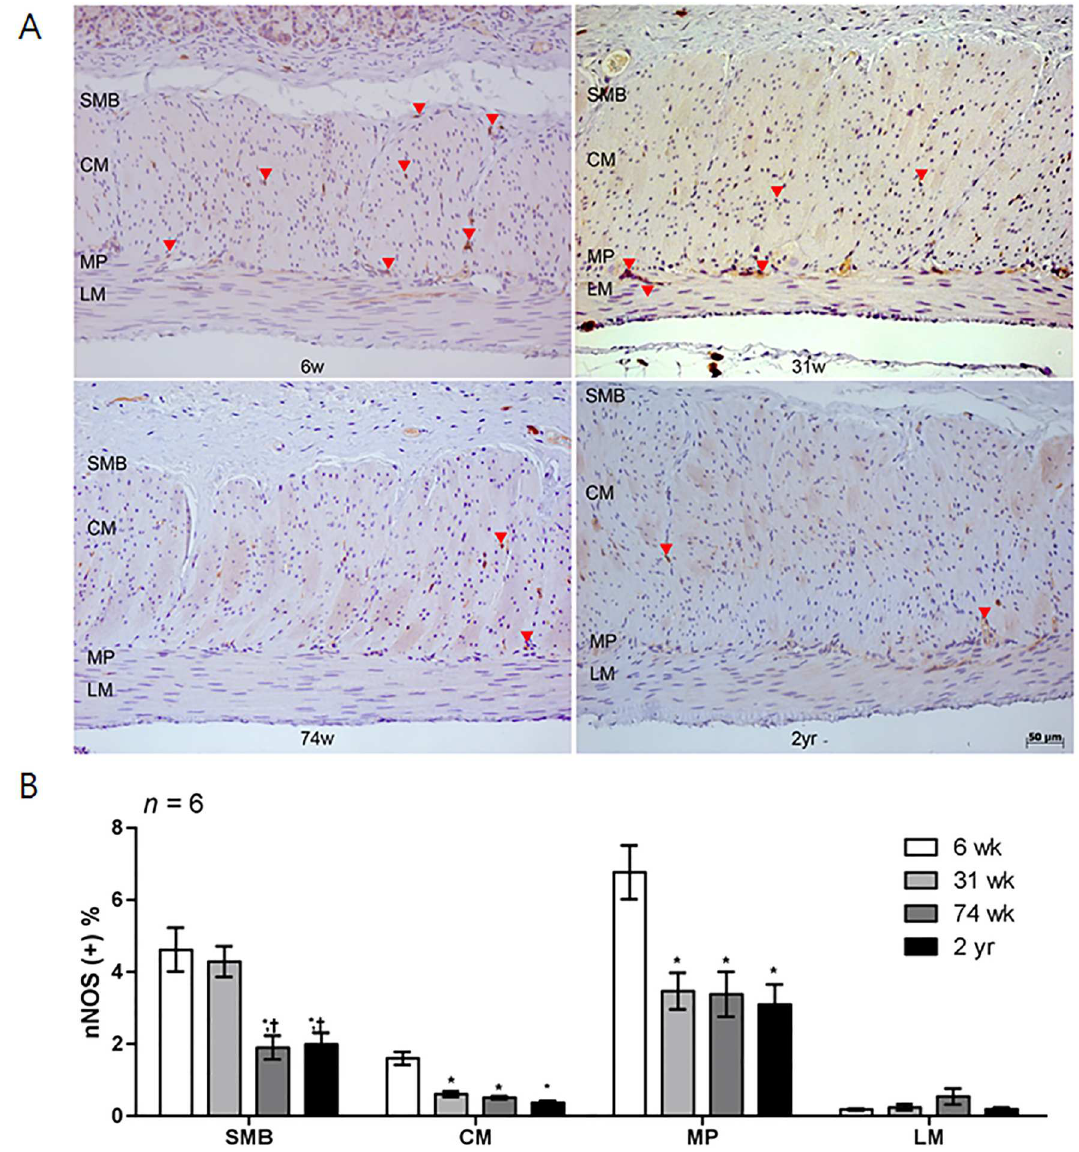
Fig 6. Analysis of nNOS immunohistochemistry. (A) Photomicrograph of nNOS immunostainingof the corpus of rat stomach. Arrows and arrowheadsindicate the nNOS-positive nerve fibers and neuronalganglion,respectively(x200 magnification). (B) Comparison of the nNOS positive area ( n = 6 per group). The proportionof the nNOS immunoreactive area decreased with age. Each bar represents the mean ± SE. SMB, submucosalborder; MP, myenteric plexus; CM, circularmuscle; LM, longitudinalmuscle. * P < 0.05 comparedwith 6-wk-old rats; † P < 0.05 compared with 31-wk-oldrats; ‡ P < 0.05 comparedwith